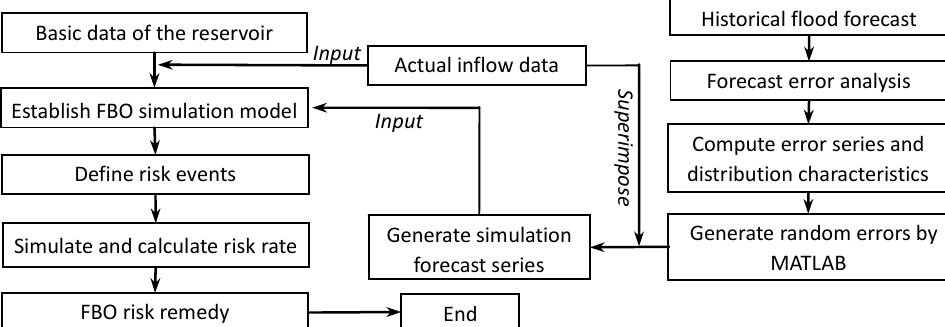
Figure 2. The risk analysis of FBO based on Monte Carlo simulation.